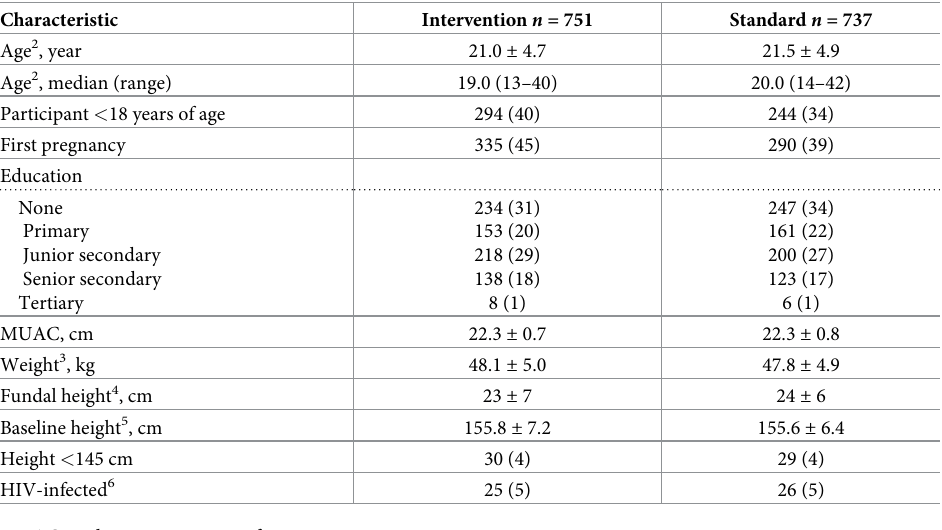
Table 1. Enrollment characteristics 1